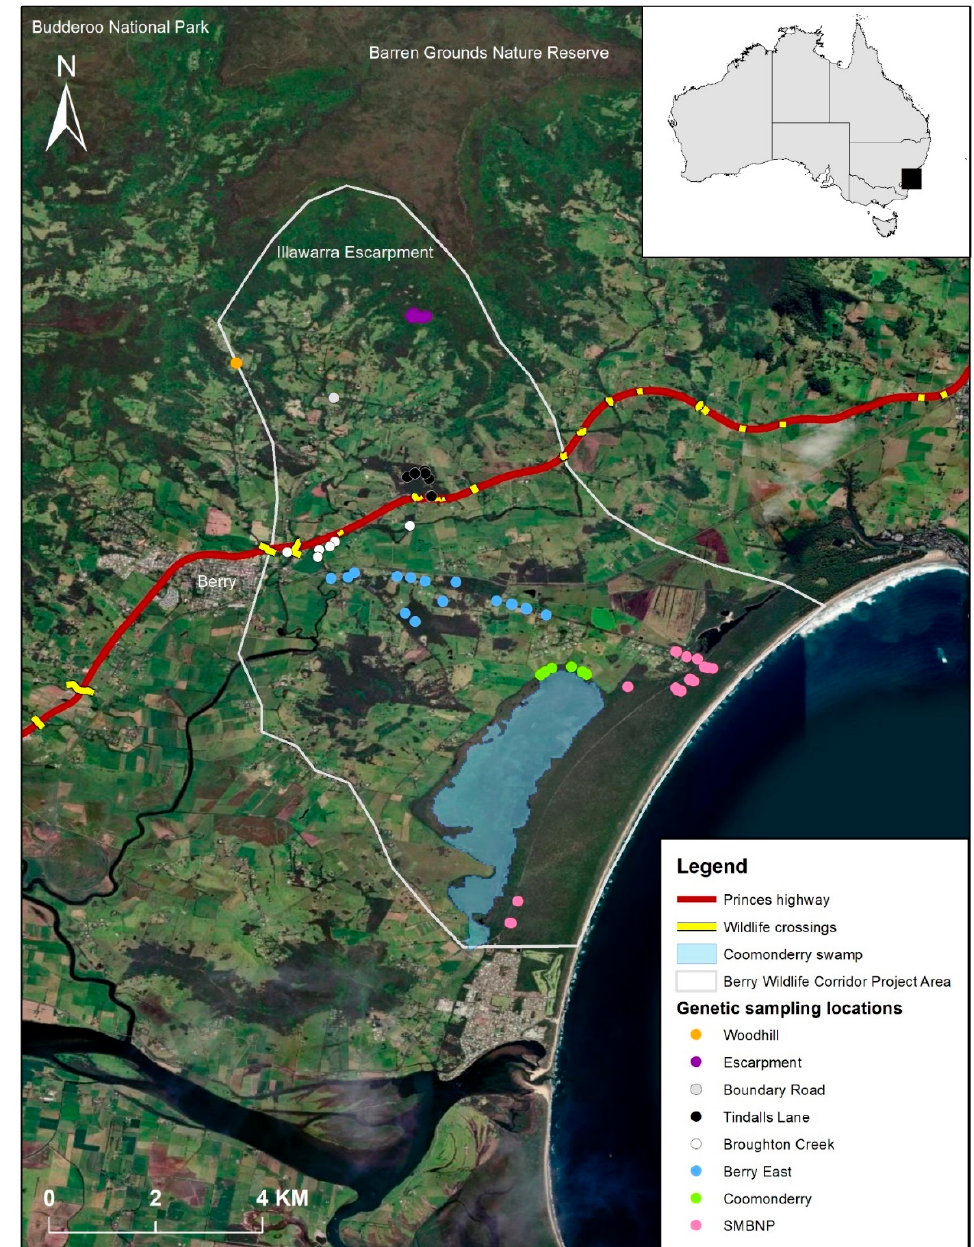
Figure 1. Location of where sugar glider ( Petaurus breviceps ) genetic samples (n = 94) were obtained from eight locations in the fragmented landscape surrounding the town of Berry, NSW, Australia. In the legend, SMBNP refers to Seven Mile Beach National Park. Upgrades to the Princes Highway were completed in 2018.